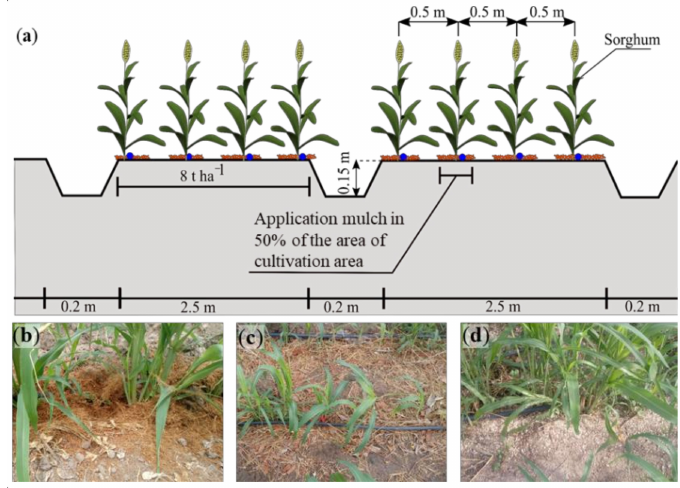
Figure 2. Sketch (not to scale) of the experimental plots ( a ) and images for the coconut coir ( b ), natural cover ( c ), and moringa seeds ( d )